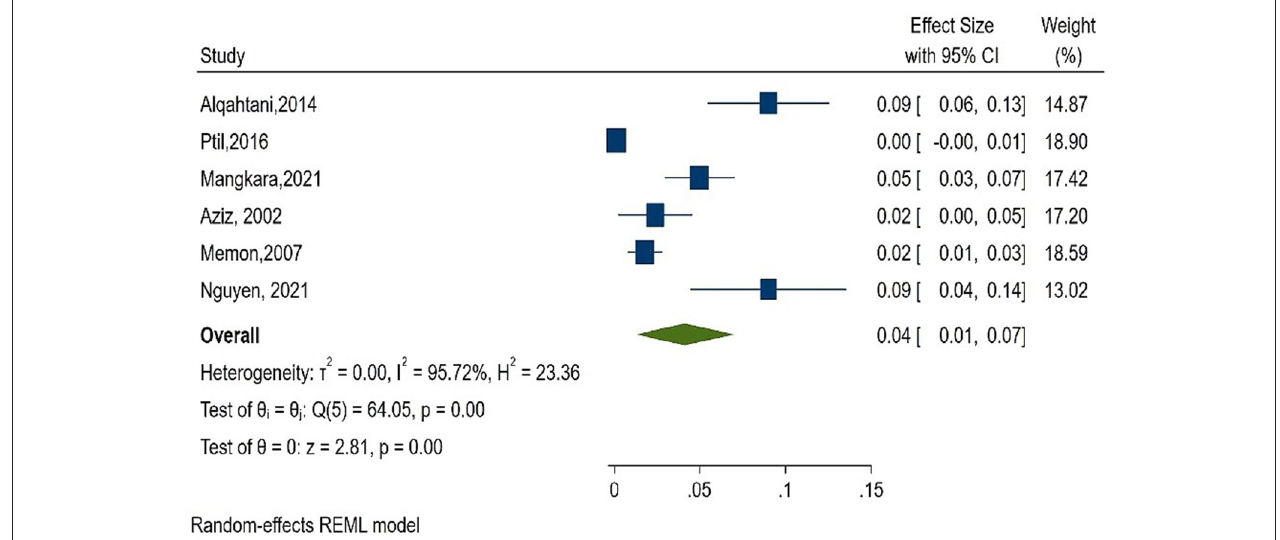
FIGURE 3 | Forest plot of seroprevalence estimate of the Hepatitis B infection among healthcare workers in Asia.